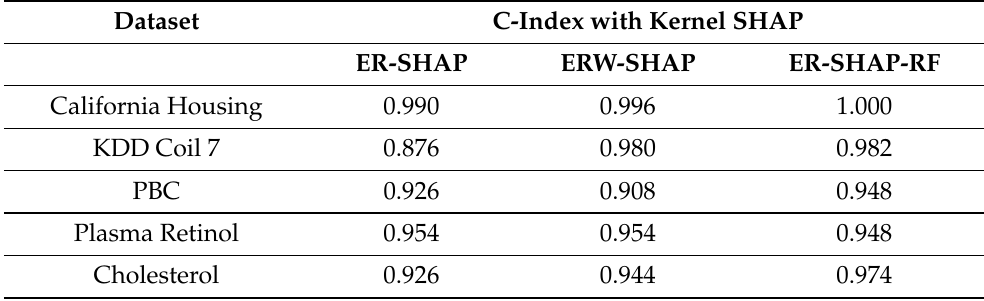
Figure 28. The heatmap reflecting the concordance index C obtained by ER-SHAP-RF for the Breast Cancer dataset with using the temperature scaling. Table 1. Comparison of the proposed models with Kernel SHAP for several datasets.